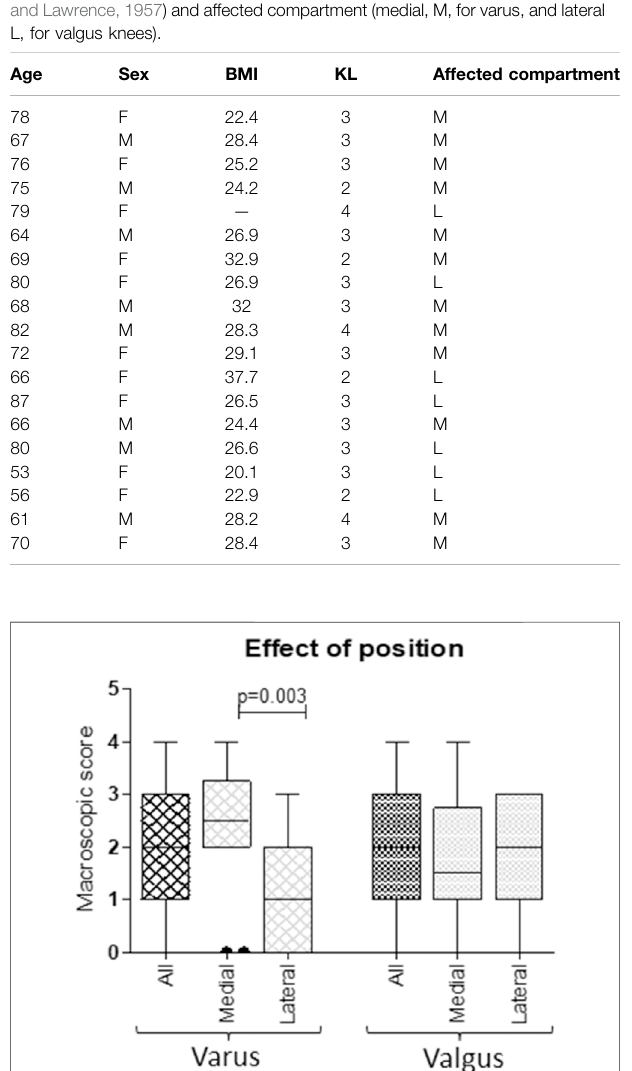
FIGURE 2 | Correspondence between macroscopic scores of medial and lateral condylar compartments and varus/valgus condition. According to knee biomechanics, higher scores in medial compartments of varus knees and higher scores in lateral compartments of valgus knees were observed (Mann Whitney U test).